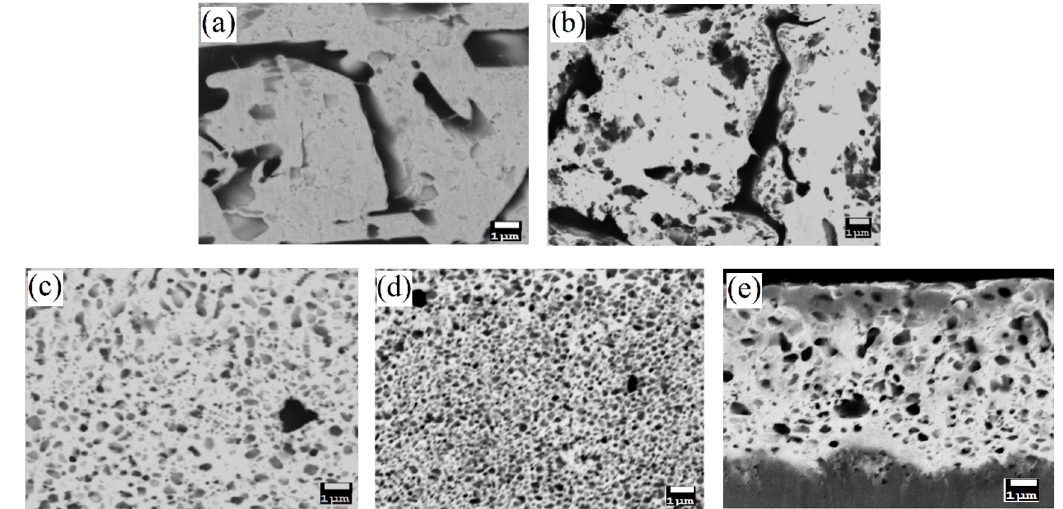
Figure 6. SEM images of joints at different soldering temperatures: 360 °C ( a ), 380 °C ( b ), 400 °C ( c ), 420 °C ( d ), and 440 °C ( e ).